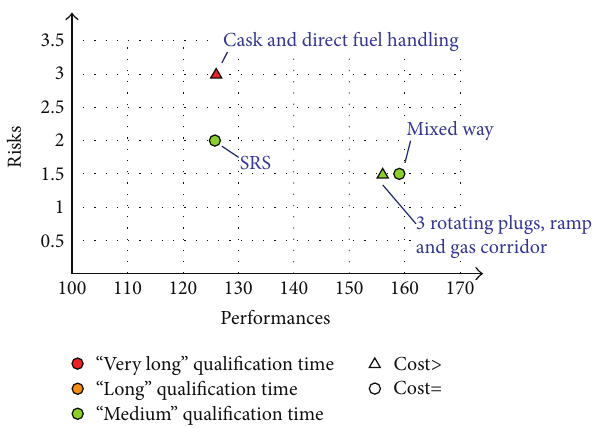
Figure 19: Graphical representation of the assessment of solutions.